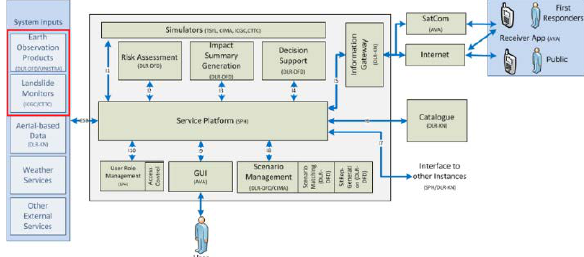
Figure 3: Scheme of the HEIMDALL project rationale. The red rectangle marks the Earth Observation and GB SAR data inputs to the Service Platform. Source: (HEIMDALL consortium,